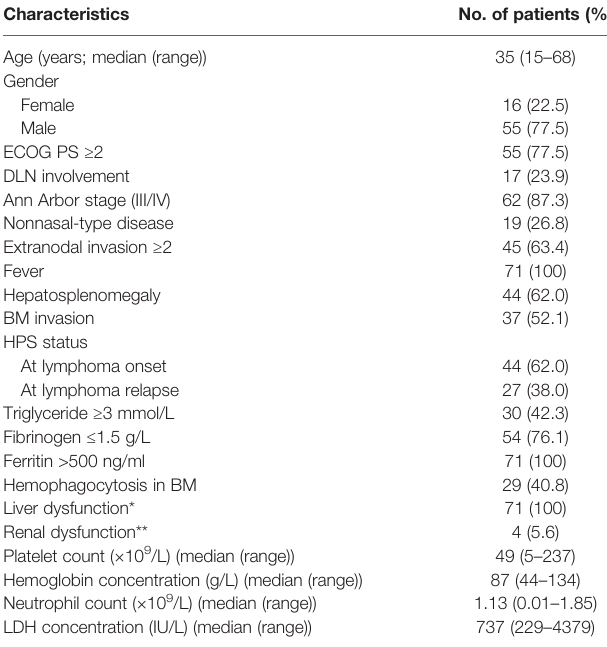
TABLE 1 | Characteristics of patients with NK/T-LAHS.